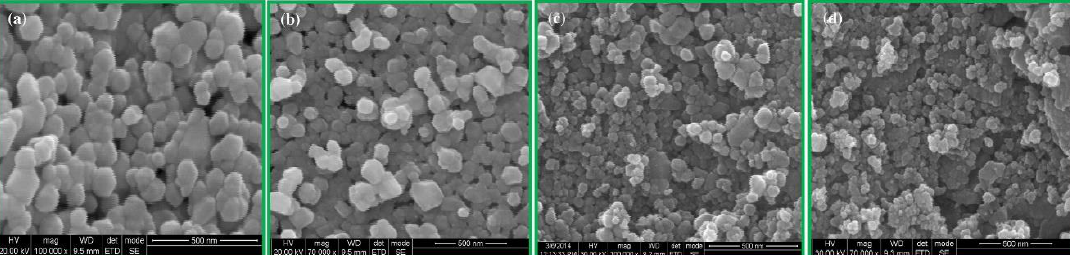
Figure 77. SEM images of Zn 1−2 x Ce x Cu x O: ( a ) Pure ZnO, ( b ) Zn 0.98 Ce 0.01 Cu 0.01 O, ( c ) Zn 0.94 Ce 0.03 Cu 0.03 O and ( d ) Zn 0.90 Ce 0.05 Cu 0.05 O. Products synthesised by the microwave induced combustion process.